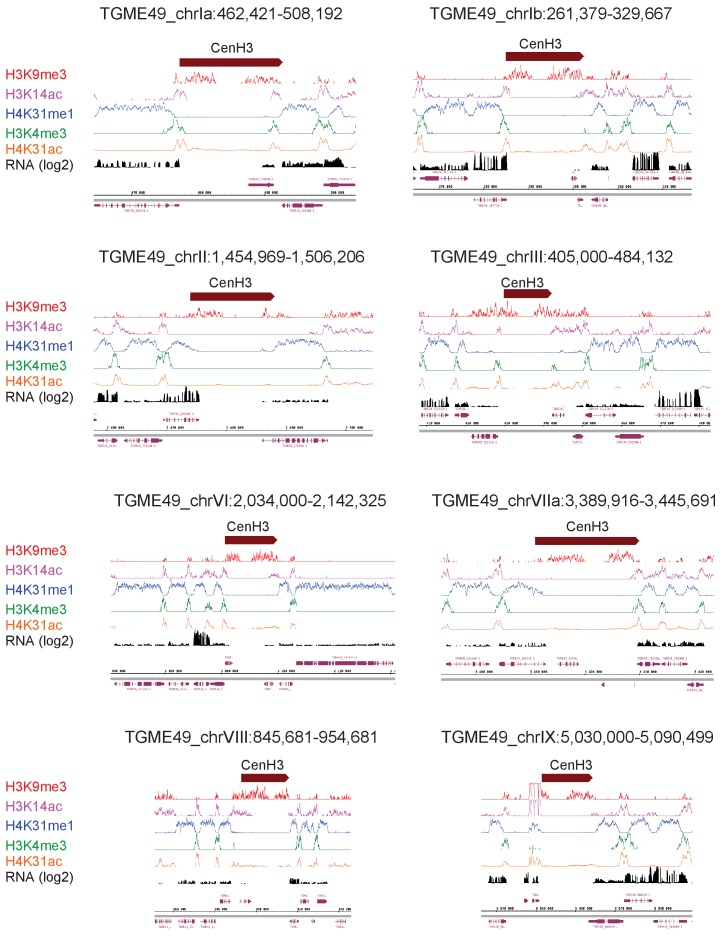
T. gondii peri-centromeric regions.(a) IGB screenshots of T. gondii peri-centromeric region of chromosomes Ia, II, III, VI, VIIa, VIII, IX and X.